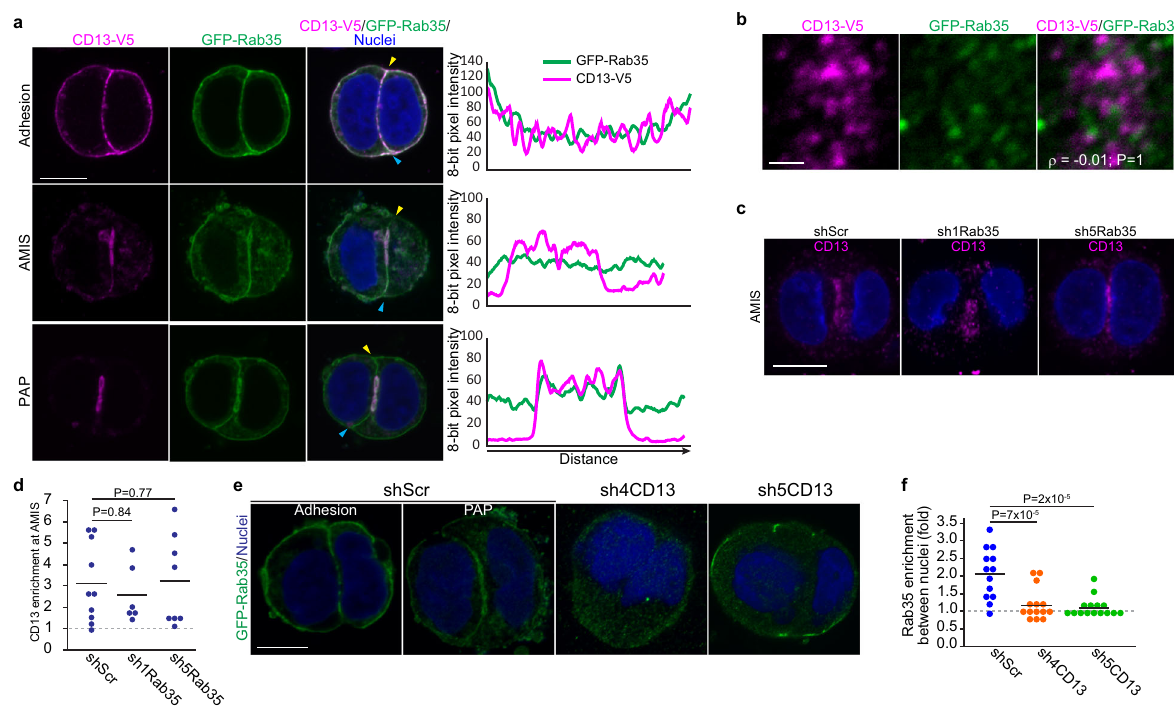
Fig. 6 CD13 acts upstream of Rab35 in apical speci fi cation. a Confocal images of Caco-2 cells grown in 3D culture for 1 days then immunostained for V5- tagged CD13 (magenta) and GFP-Rab35 (green) at initiation stages of polarization (Adhesion, AMIS, PAP). Line tracings showing CD13 and Rab35 pixel intensity along the cell-cell contact surface from yellow to cyan triangles are shown to the right. b Confocal images of Caco-2 cells showing CD13-V5 (magenta) and GFP-Rab35 (green) vesicles. Object-based colocalization was performed for CD13 and Rab35 and produced a correlation ef fi cient ρ = − 0.01. c Confocal images of control (shScr) or Rab35 knock-down (sh1-Rab35, sh5-Rab35) Caco-2 cells immunostained for endogenous CD13 (magenta). d Quanti fi cation of internuclear enrichment of CD13. Dots represent individual Caco-2 structures from a single experiment. e Confocal images of control (shScr) and CD13 knockdown (sh4-CD13 and sh5-CD13) Caco-2 cells showing GFP-Rab35 direct fl uorescence. f Inter-nuclear enrichment of GFP-Rab35 was calculated as the mean internuclear intensity divided by mean cytoplasmic intensity excluding the inter-nuclear region for the conditions indicated ( n = 13 shScr, n = 14 sh4CD13, n = 15 sh5CD13 cell structures). Data are representative of two independent experiments. p -values were calculated by ANOVA with Tukey ’ s posthoc test for multiple comparisons ( d , f ). Images are representative from 2 independent experiments. Bars: a , c , e , 10 μ m; b , 2 μ